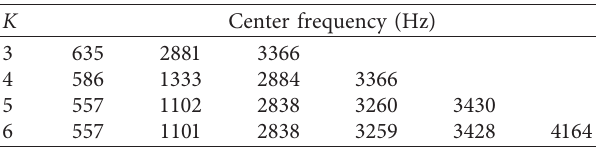
Table 1: The center frequency of components with different K values.